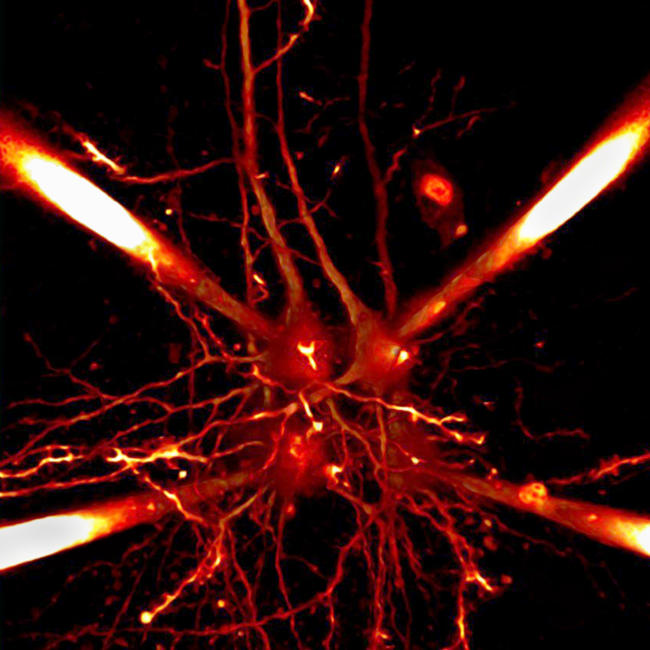
Recording multiple neurons simultaneously